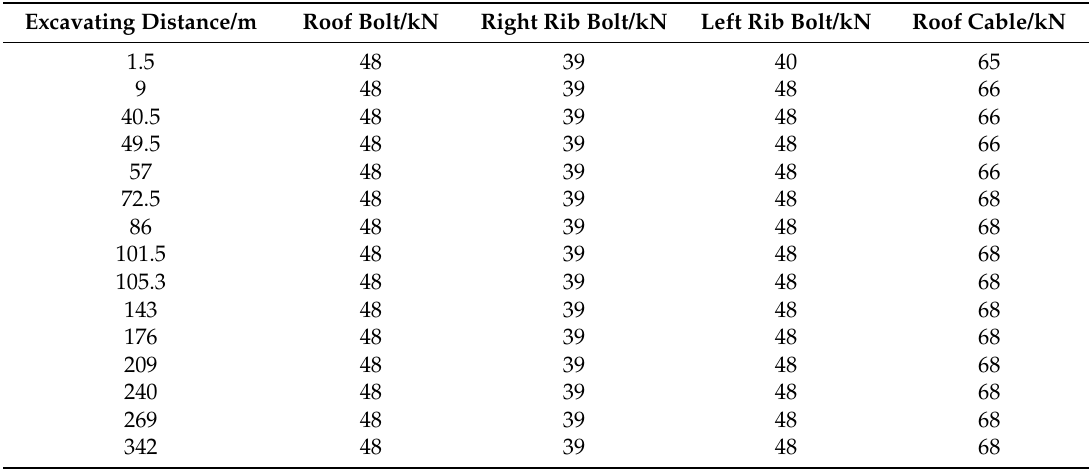
Table 5. Stress variation of the bolt and cable with the roadway excavation.